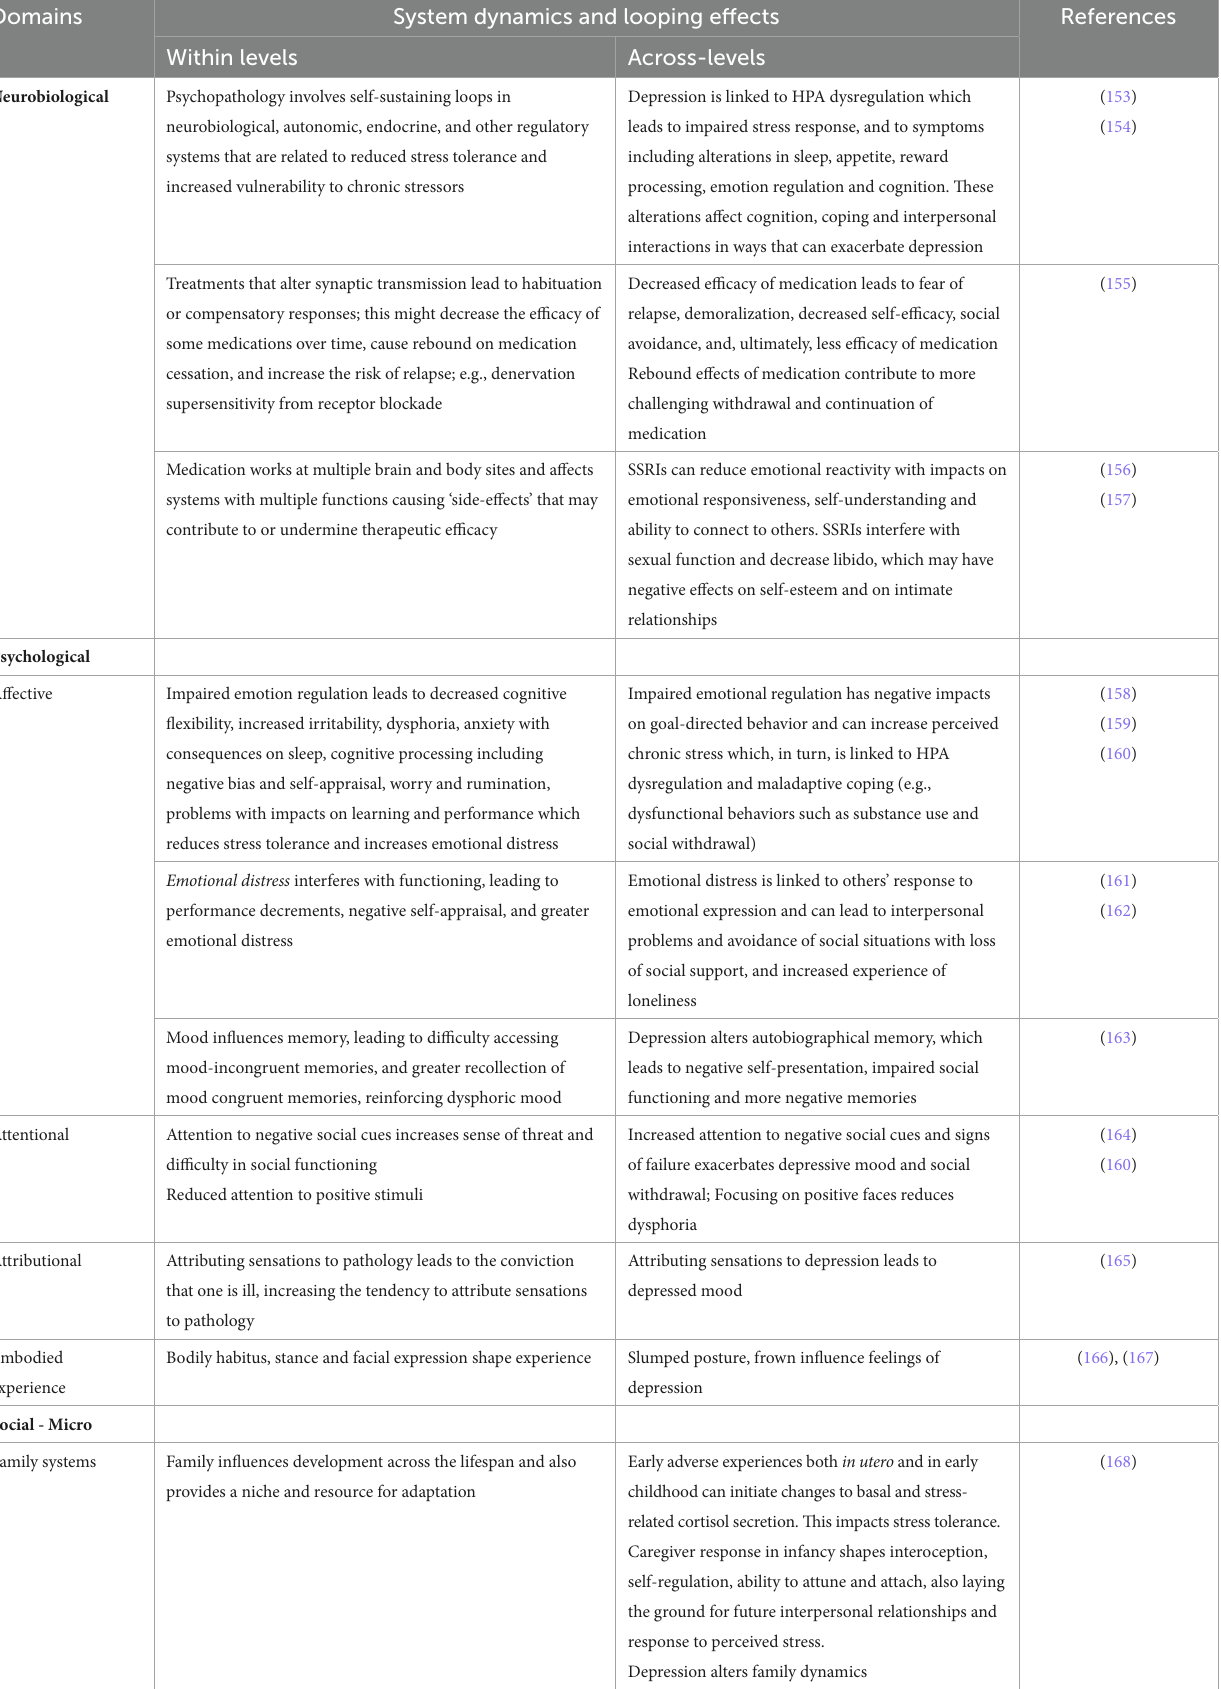
TABLE 1 Examples of Looping Effects Related to the Mechanisms of Depression and Treatment Response.